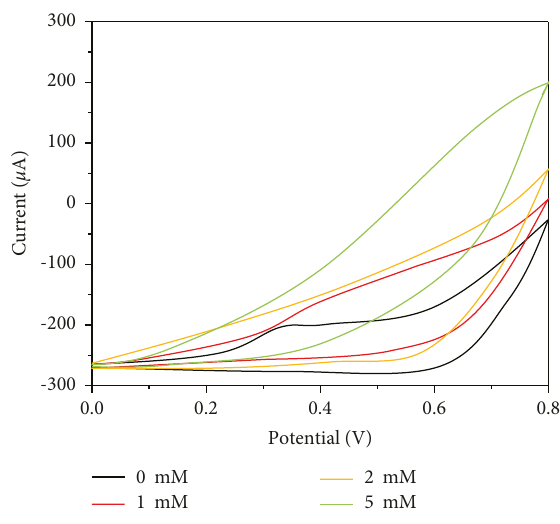
Figure 4: CV of CuNW/SPCE for 0–5 mM UA in 0.1 M NaOH with a scan rate of